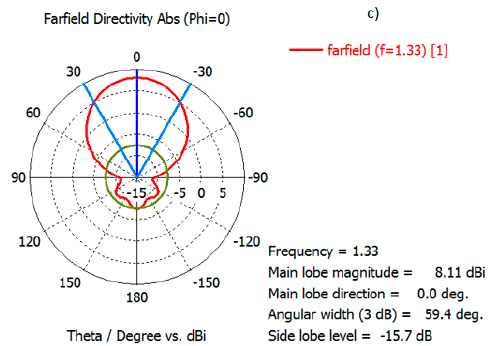
Figure 14. Results obtained with FR-4 for 0° .